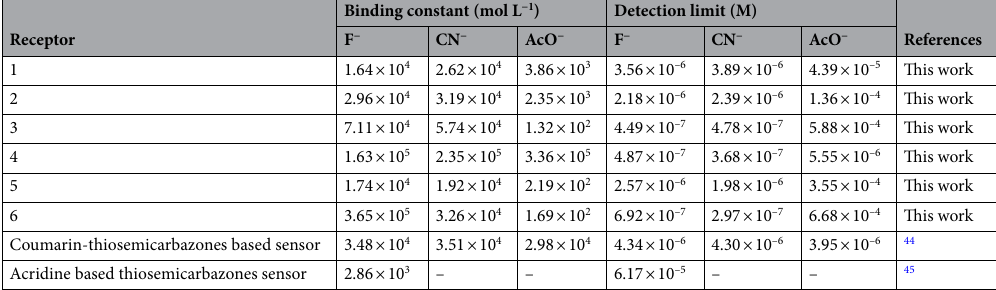
Table 1. Binding constants and detection limit values of receptor (1–6) in